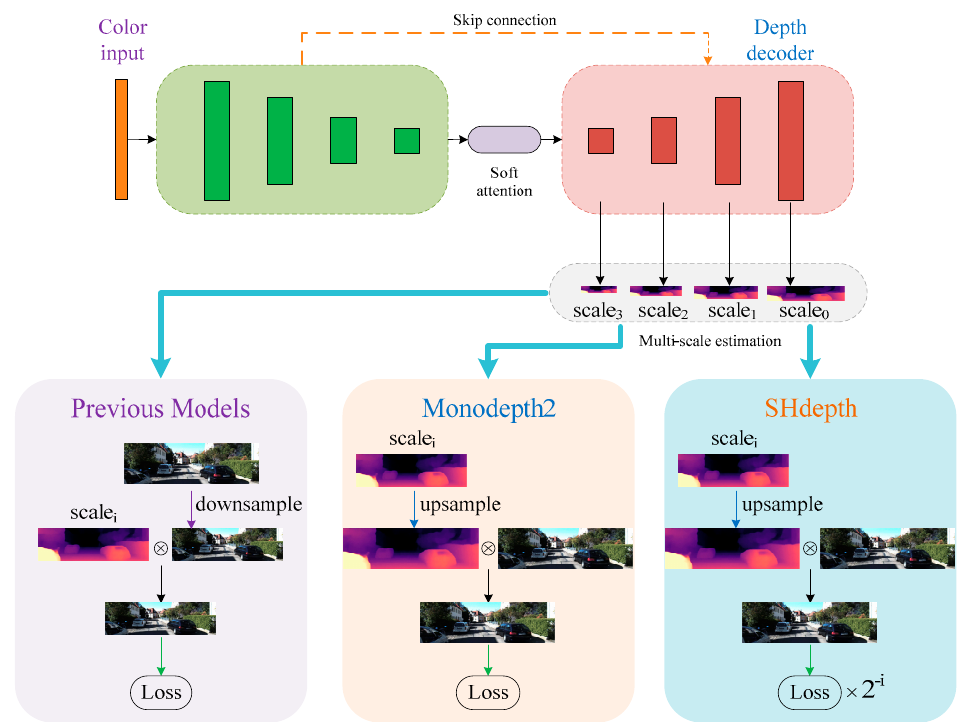
Figure 4. Hard attention strategy in SHdepth. We compared the details of our hard attention strat- egy with Monodepth2 and other previous methods. All of them utilize information from multi-scale depth maps during